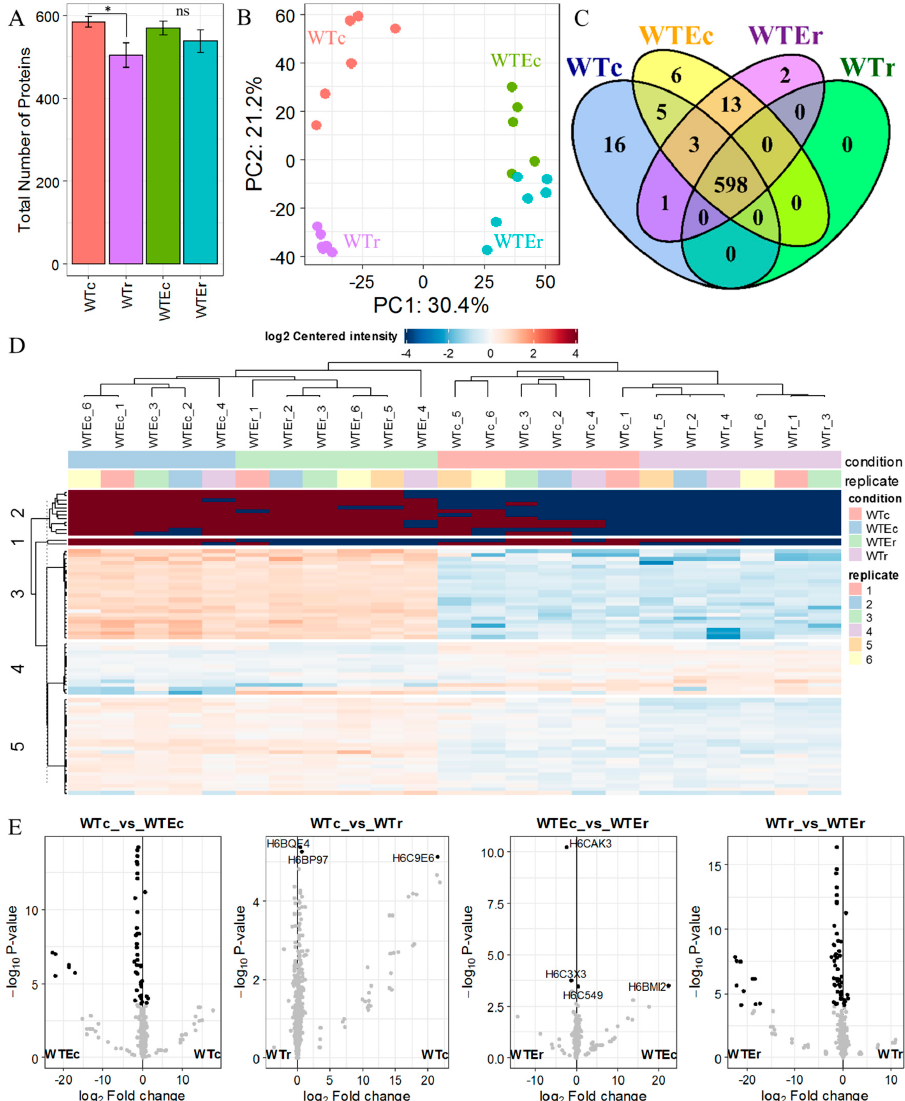
Figure 2. Proteomic response to γ -radiation exposure in WT and Evolved Exophiala dermatitidis strains. ( A ) Total number of proteins identified in each condition. * indicates significance (ANOVA, p < 1 × 10 − 5 ). ( B ) PCA of the total proteomic dataset. Each point represents a biological replicate with color corresponding to condition. ( C ) Venn diagram depicting overlap of proteins identified in greater than 4 replicates of each condition (>3 for the Evolved control). ( D ) Heatmap of significantly differentially enriched proteins. Each row represents a single protein and each column represents one replicate, grouped by k-means clustering. Cell colors represent abundance values in comparison to a centered intensity. ( E ) Volcano plots of pairwise comparisons, with –log 10 unadjusted p -values plotted against the log 2 fold change. Black points represent differentially enriched proteins at α = 0.05 after FDR adjustment. (WTc = WT cultures with no radiation exposure; WTr = WT cultures exposed to radiation; WTEc = evolved WT strain with no radiation exposure; WTEr = evolved WT strain exposed to radiation).